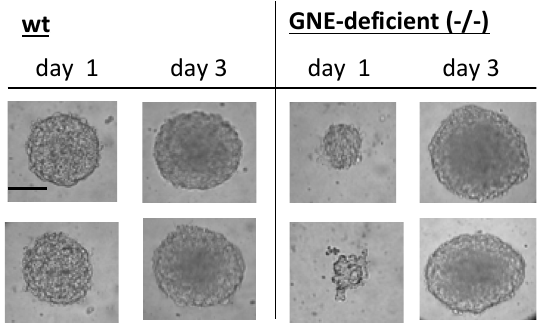
Figure 2. Embryoid body formation. Wild-type (wt) and GNE-deficient embryonic stem cells (GNE-deficient ( − / − )) were cultured in hanging drops in FCS containing medium for 24 h or 72 h. Representative micrographs were shown. Bar = 100